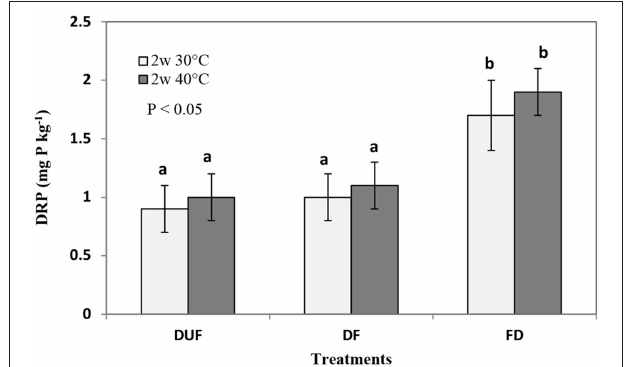
FIGURE 4 | Microbial biomass phosphorus (mg P kg − 1 ) extracted in samples dried for 2 and 14-days followed by fumigation (DF) treatments at 30 and 40 ◦ C. Error bars represent standard deviation (for some columns error bars are too small to be seen), n = 3. Means with the same letter are not significantly different from each other at the significance level of P < 0.05 as determined using Tukey’s post-hoc test. *Moist control is reference moist soil (MF) stored at 3 ◦